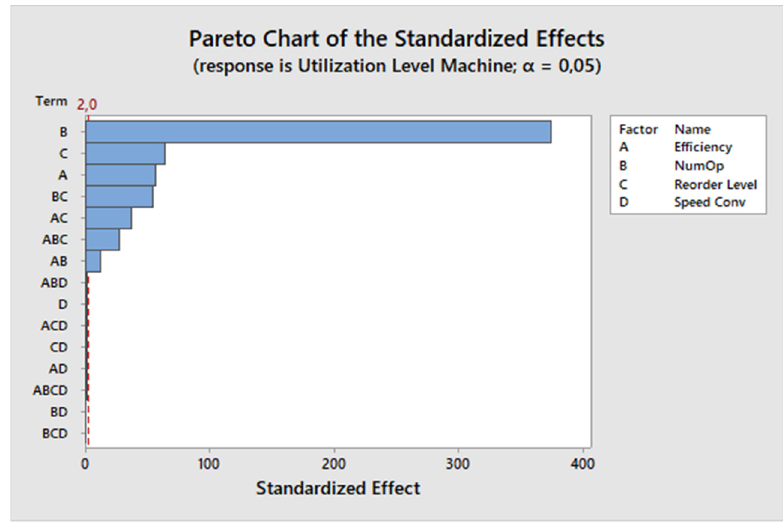
Figure 16. Pareto Chart of the Standardized Effects for Utilization Level Machine.